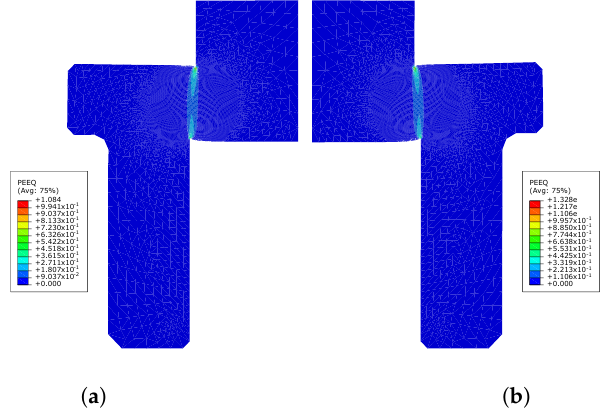
Figure 18. Equivalent plastic strain contour-plots of the complete model and simplified model for dynamic shear test. ( a ) Equivalent plastic strain contour-plot of the complete model; ( b ) Equivalent plastic strain contour-plot of the simplified